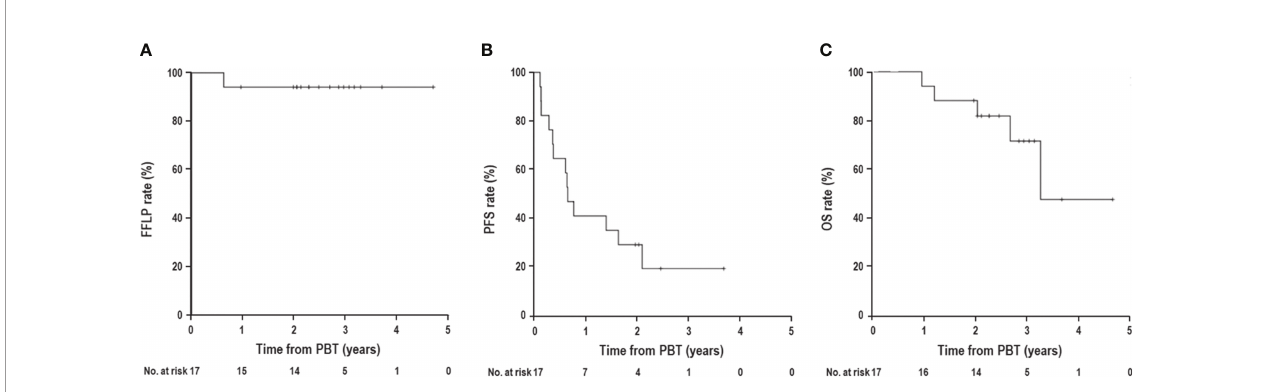
FIGURE 3 | (A) Freedom from local progression (FFLP), (B) progression-free survival (PFS), and (C) overall survival (OS) curves in patients with liver metastasis from breast cancer receiving proton beam therapy